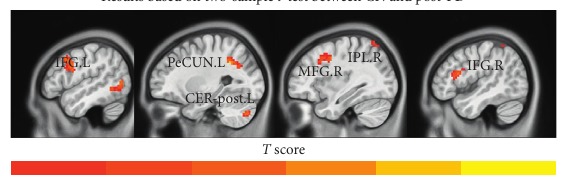
Figure 3: Comparisons of functional connectivity between CN and post-PD ( p < 0 . 001, FDR corrected and cluster extent k > 30 vox- els). Abbreviations: CN, normal controls; post-PD, postoperation Parkinson’s disease; ECN, executive control network; IFG.L, left inferior frontal gyrus; PeCUN.L, left precuneus; CER-post.L, left cerebellum posterior lobe; MFG.R, right middle frontal gyrus; IPL.R, right inferior parietal lobule; IFG.R, right inferior frontal